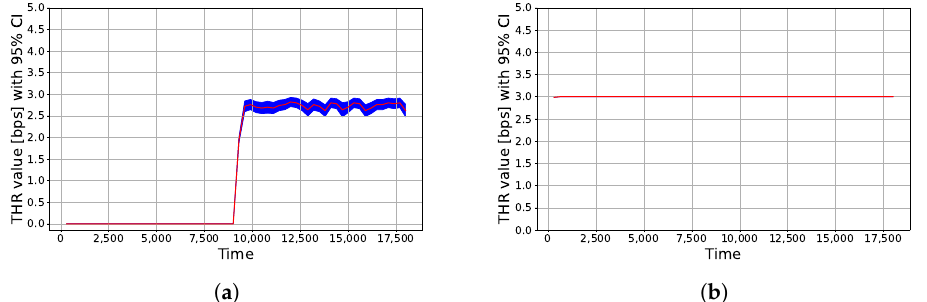
Figure 11. “Instantaneous” throughput values yielded by UWPhysical module from node 1 to node 3 ( a ) and from node 4 to node 2 ( b ).